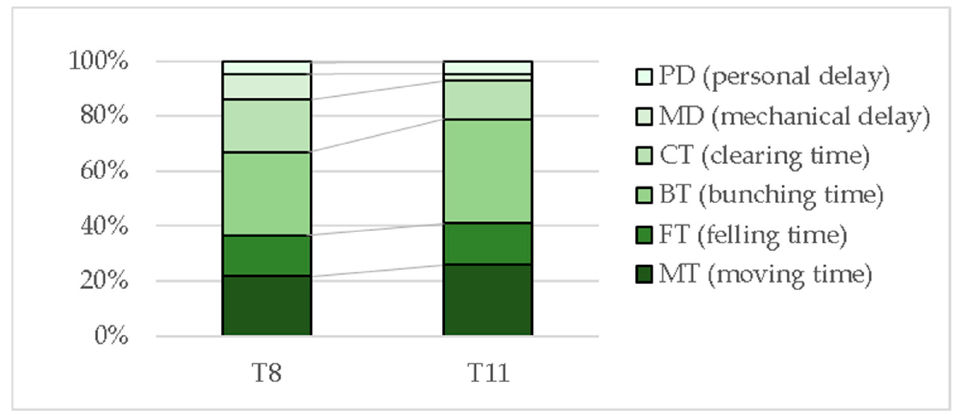
Figure 4. Percentage incidence of the single working phases per tree in plantations T8 and T11.